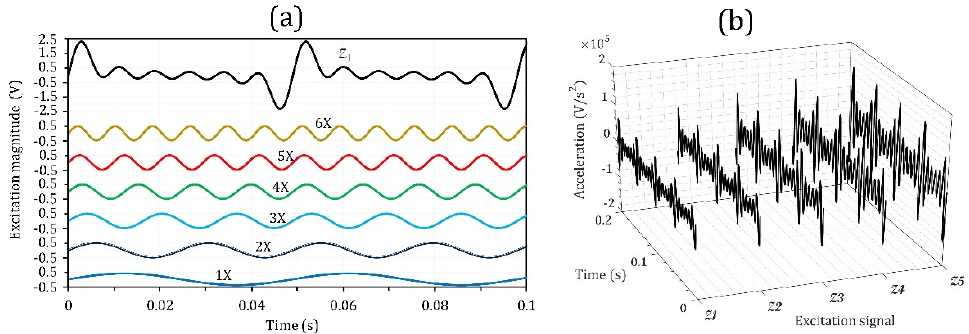
Figure 7. ( a ) Standard multi-harmonic base excitation signal and ( b ) applied acceleration for multi- harmonic base signals.